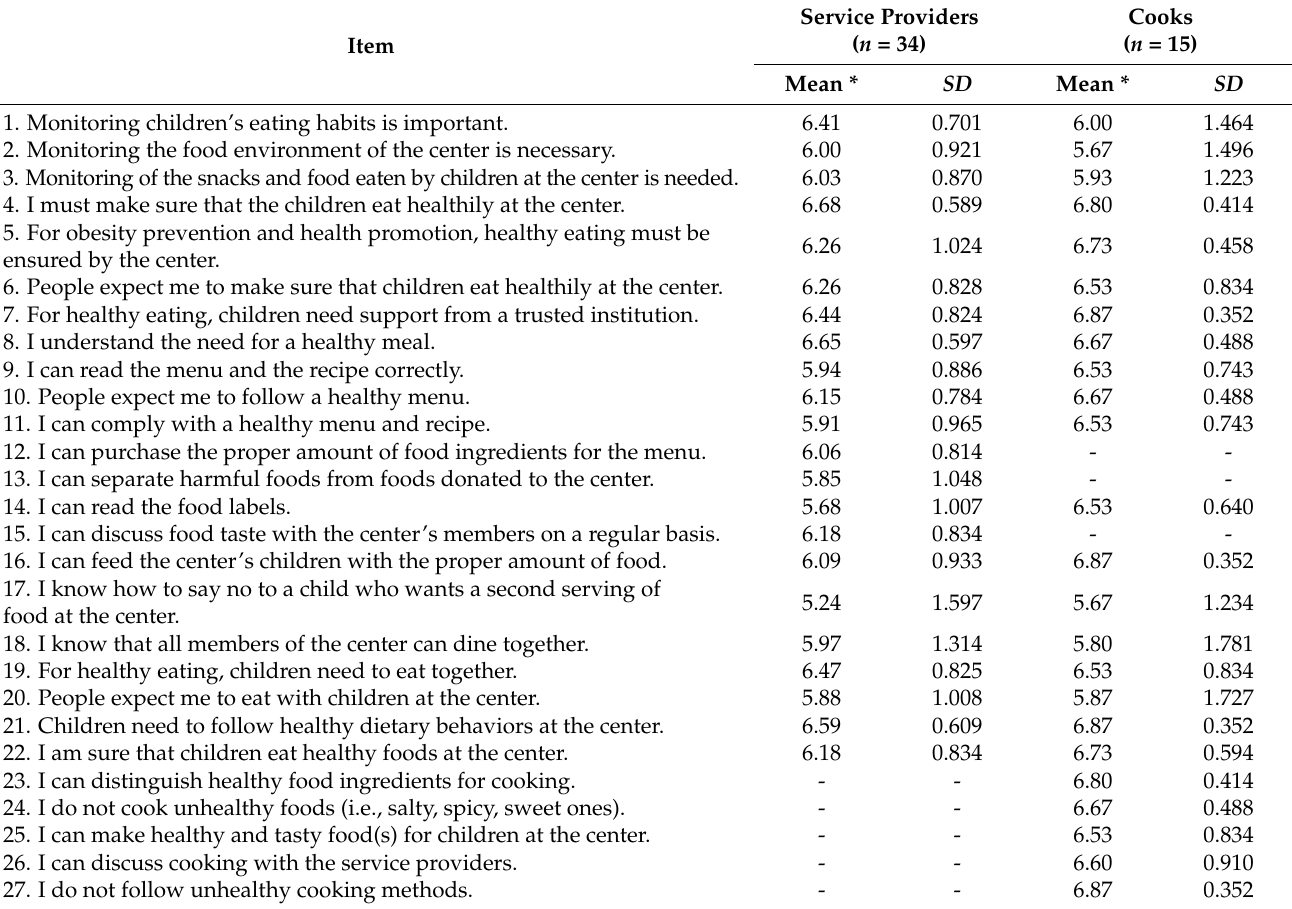
Table 3. Service providers’ and cooks’ intentions toward eating practices at